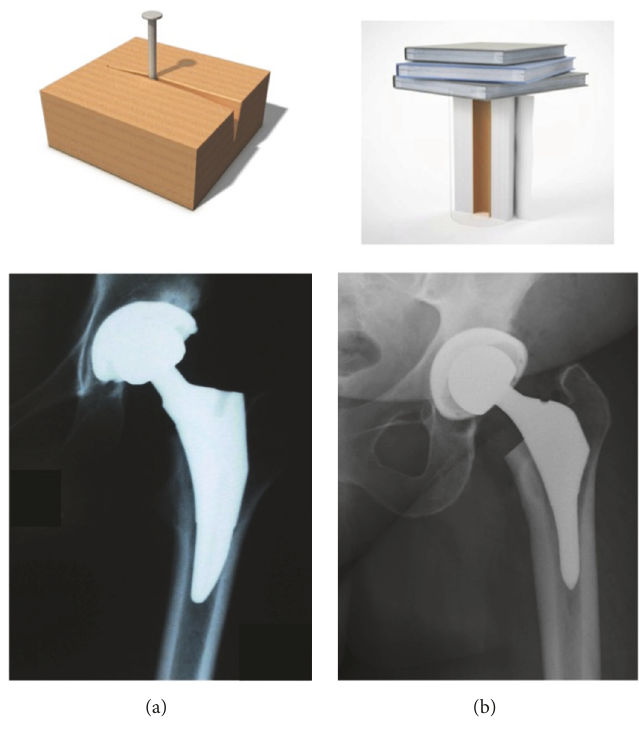
Figure 5: Press fit (a) vs rest fit